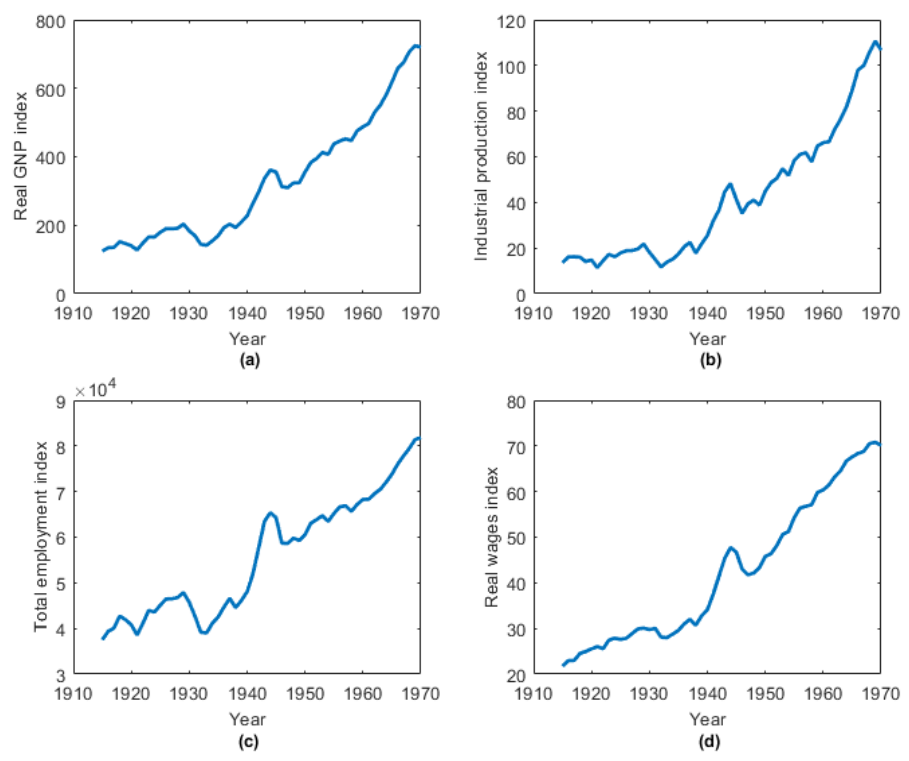
Figure 1. Macroeconomic indexes of the U.S. from 1915 to 1970: ( a ) real gross national product ( GNPR ); ( b ) industrial production index ( IPI ); ( c ) total employment index ( E ); ( d ) real wages ( WR ).